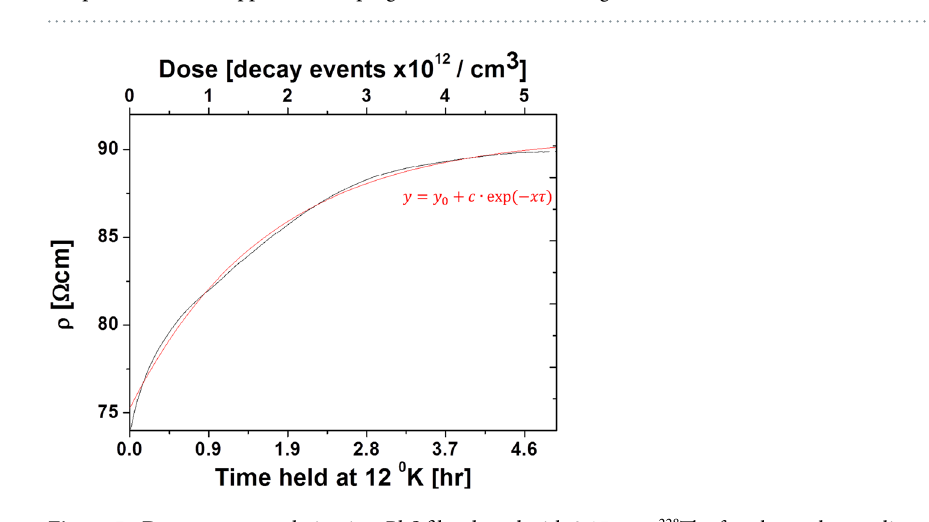
Figure 4. Temperature dependent resistivity measurements from room temperature to 12 °K on the various PbS films: ( a ) 0.2 at% 232 Th doping. ( b ) 0.15 ppm 228 Th doping accumulating damage for 6 months at room temperature. ( c ) 0.15 ppm 228 Th doping after thermal annealing at 548 °K for 3 hr.